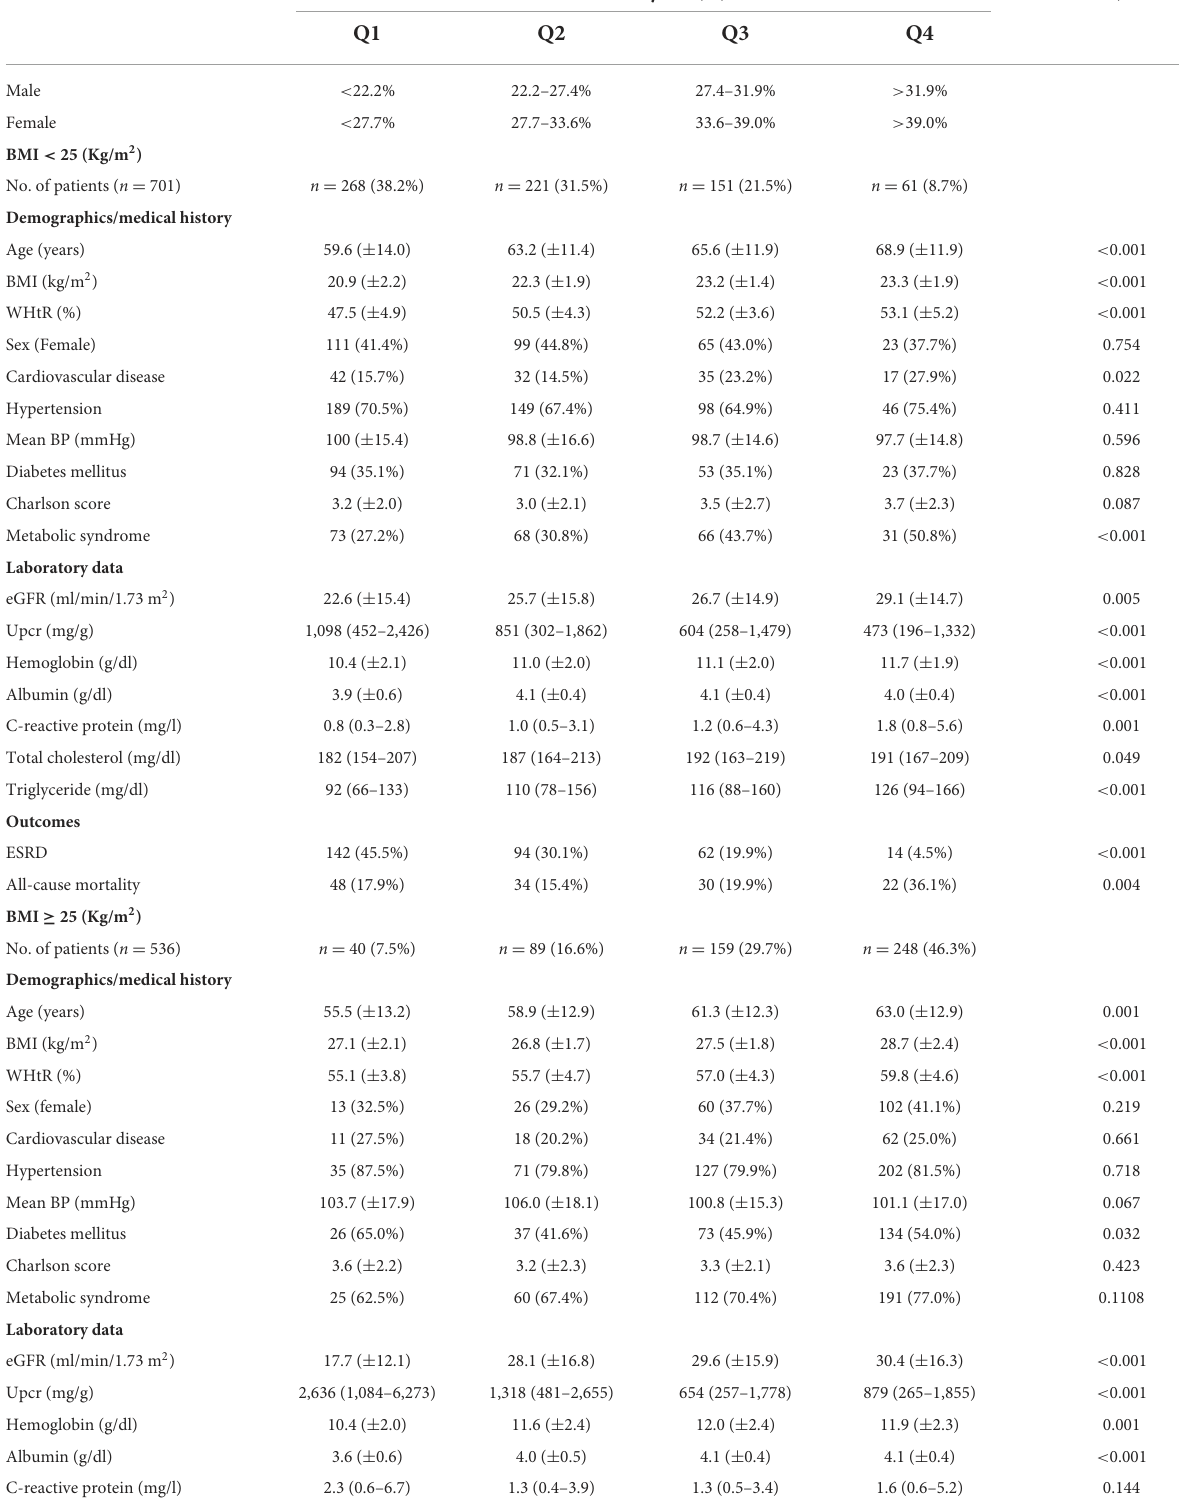
TABLE 2 Baseline characteristics of patients with stage 3–5 chronic kidney disease stratified by total body fat and body mass